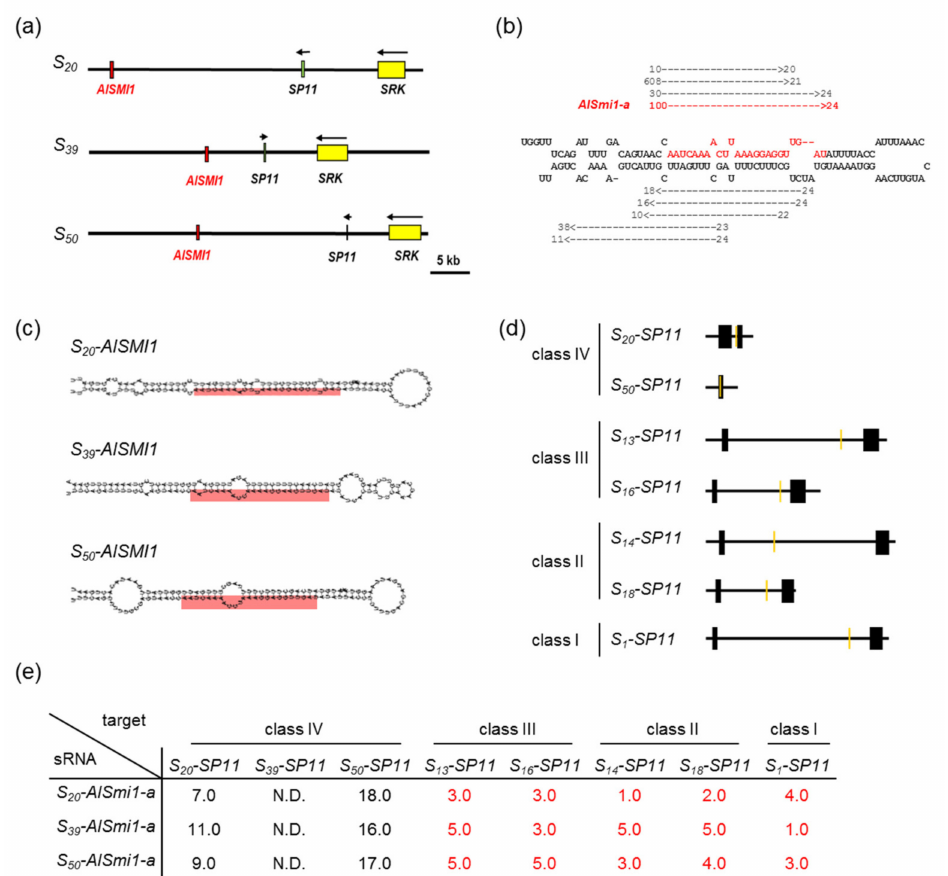
Figure 2. Identification of candidate sRNAs controlling the dominance–recessivity relationships: class IV > (class III, class II, class I). ( a ) Schematic diagrams of the S locus in the S 20 haplotype (HQ379628), S 39 haplotype (KJ772418–KJ772419), and S 50 haplotype (HQ379631). Green, yellow, and red boxes indicate SP11 , SRK , and AlSMI1 , respectively. ( b ) Massively parallel sequencing analysis of sRNA expression from the AlSMI1 inverted repeat sequence. sRNAs that obtained at least 10 reads were mapped against the AlSMI1 inverted repeat sequence. Arrows indicate mapped sRNAs and their directions. Numbers at the tips of arrows indicate the number of obtained sRNA reads, and numbers at the ends of arrows indicate the length of each sRNA (in nucleotides). Bases in red represent the 24-nt AlSmi1-a region. ( c ) Stem-loop structures of AlSMI1 of the S 20 , S 39 , and S 50 haplotypes predicted by RNAfold [20]. The predicted mature 24-nt AlSmi1-a region is shown in red. ( d ) Schematic diagrams of the S 20 , S 50 , S 13 , S 16 , S 14 , S 18 , and S 1 -SP11 genomic regions. Black boxes indicate exon regions of SP11 genes, orange boxes indicate regions with high sequence similarity to AlSmi1-a . ( e ) Sequence similarity between AlSmi1-a and SP11 . Each number shows the mispair score between the class IV ( S 20 , S 39 , S 50 ) - AlSmi1-a and the SP11 introns of class-IV, class-III, class-II, and class-I S haplotypes. N.D., not detected. Mispair scores < 5.5 are shown in